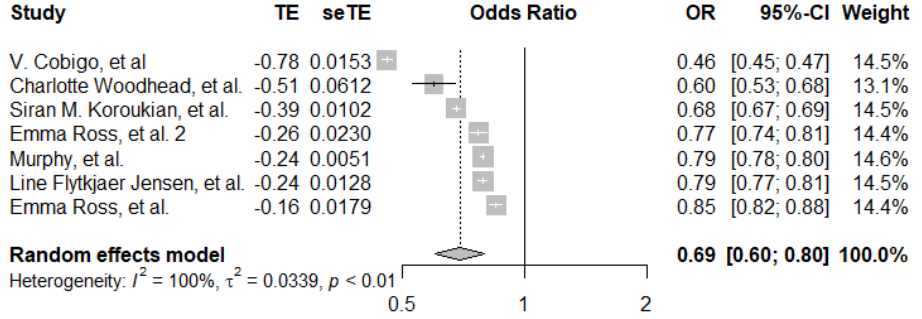
Figure 5. Pooled adjusted odds ratio estimates of breast cancer screening uptake by psychosocial disability status [26–28,33–36].